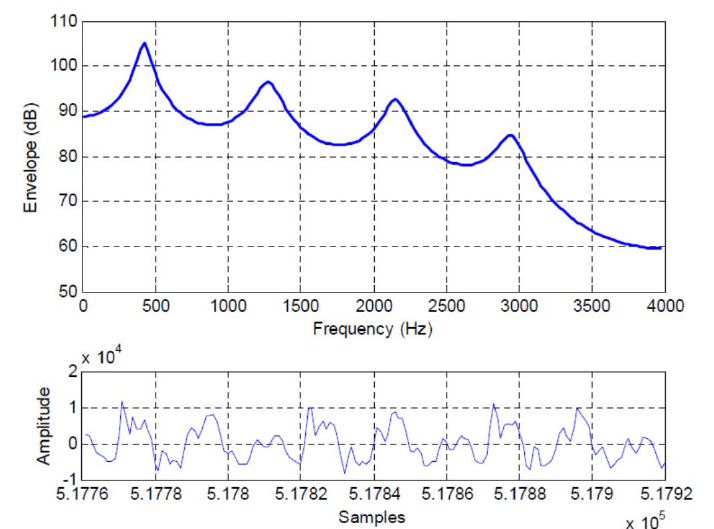
Figure 6. Frame 3237 time domain waveform (bottom) and spectral envelope, signal-to-prediction error (SPER) = 9.15 dB. Table 2. Change in mutual information from Equation (17) for 10th order predictors and corresponding SPERs for several speech frames